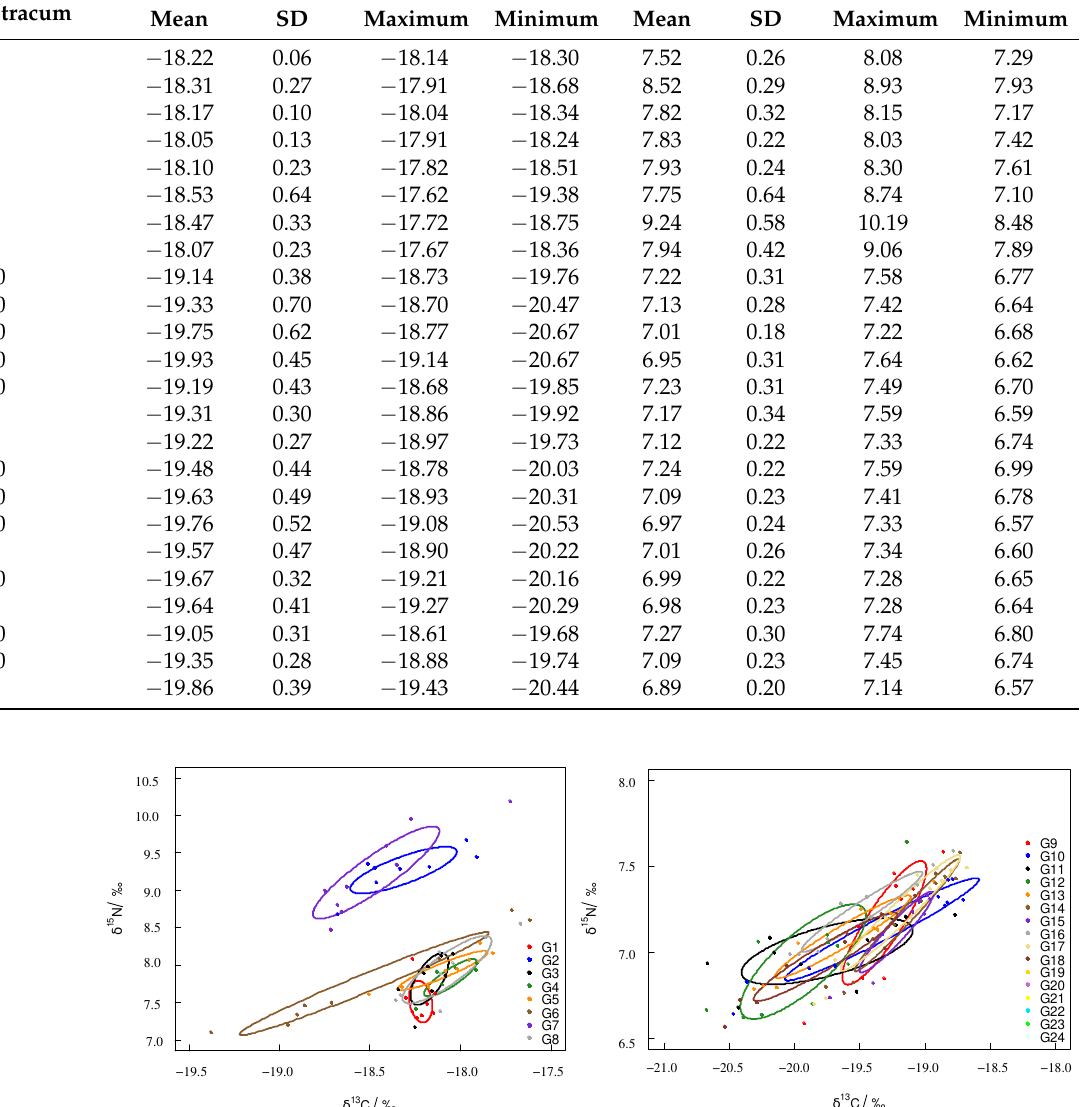
Figure 3. Trophic niche of T. pacificus collected in the East China Sea and the Sea of Japan (circle plot: